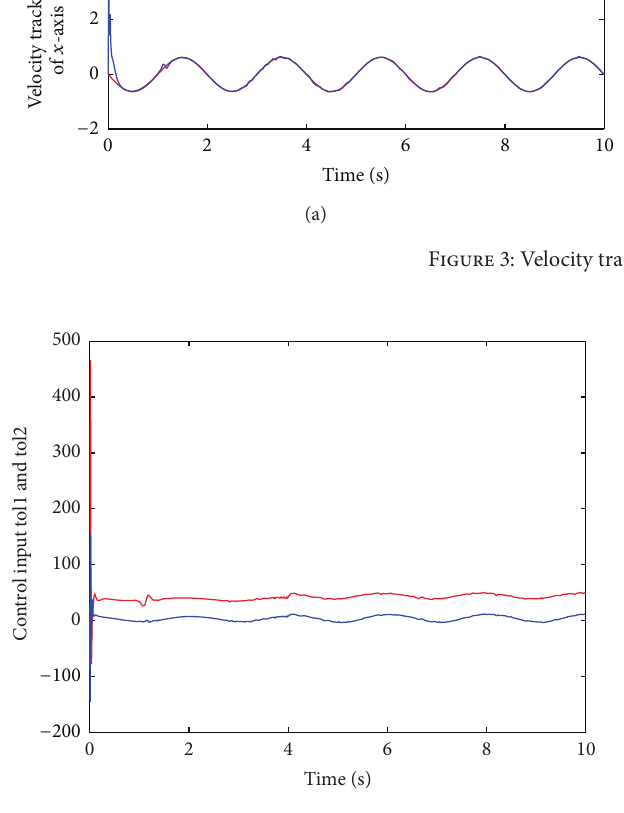
Figure 4: The control inputs of the end